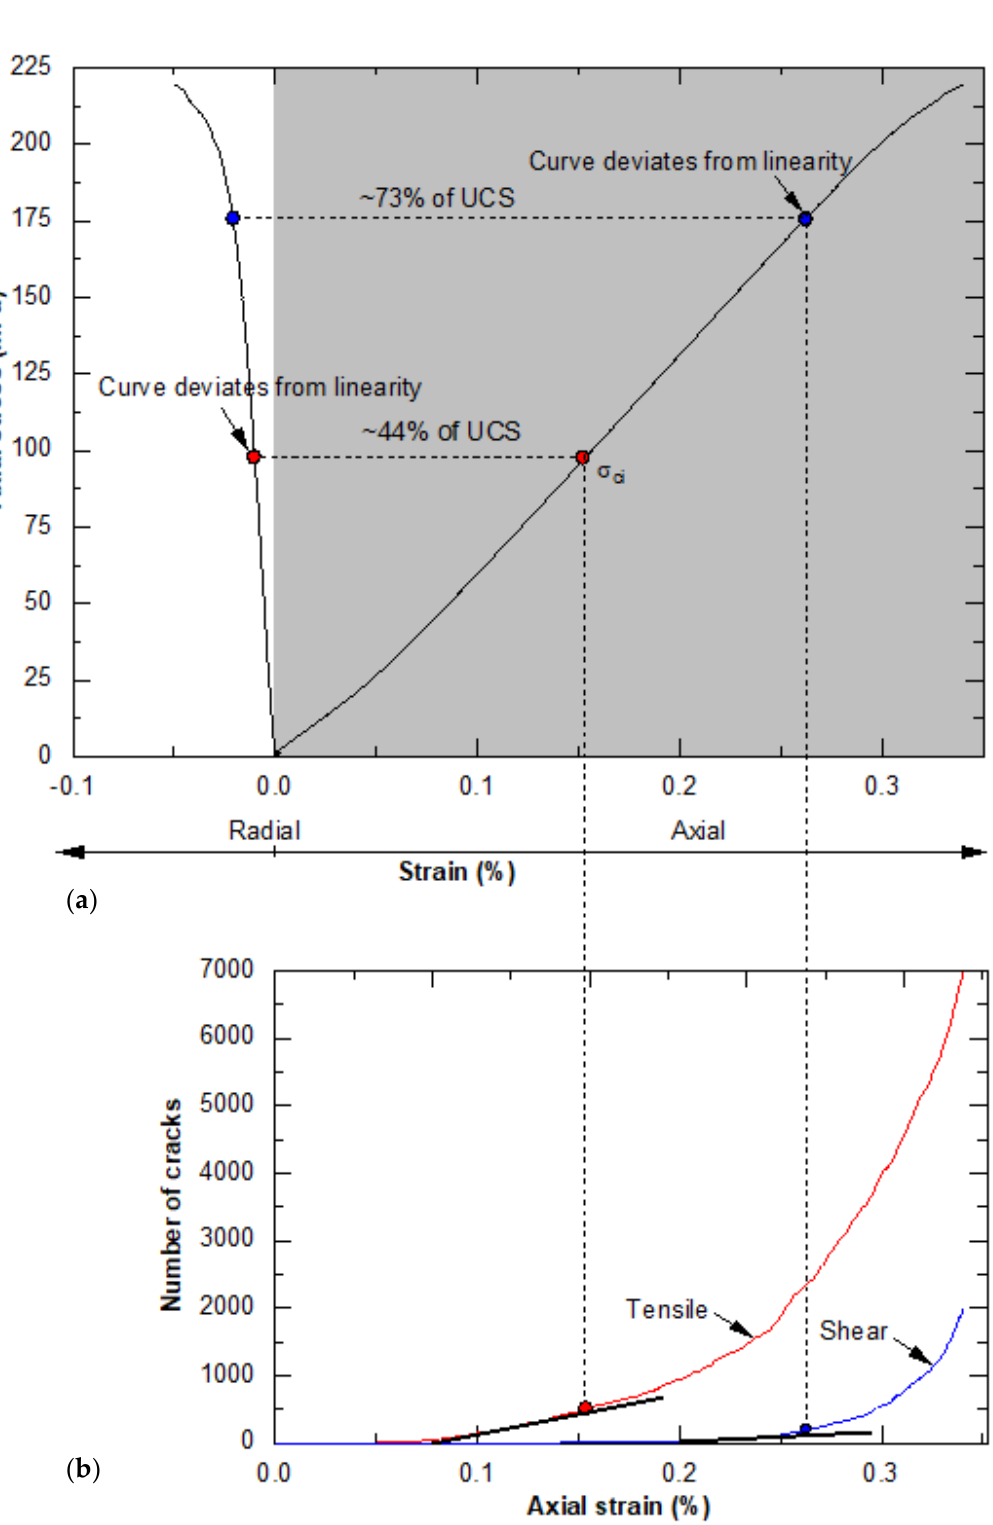
Figure 7. Results of the UCS test for the numerical sample. ( a ) shows the axial stress versus the axial and radial strain and ( b ) shows the generation of tensile and shear cracks with axial strain.